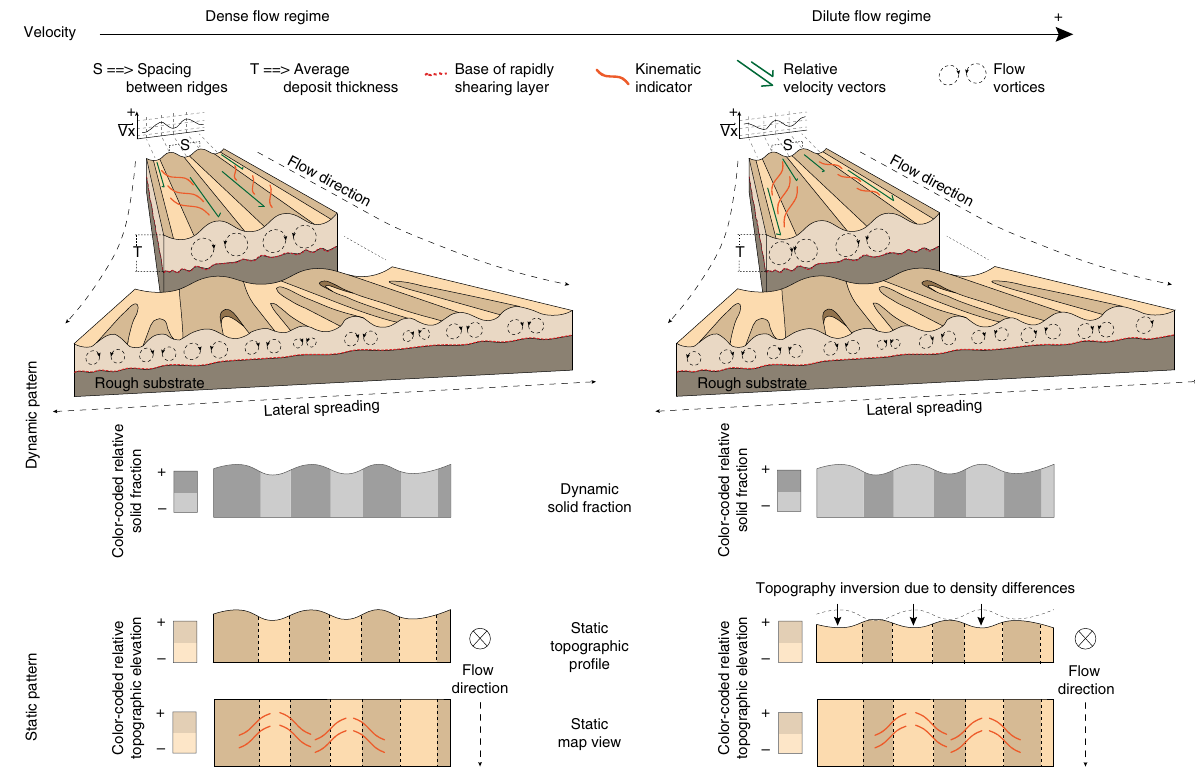
Fig. 4 Flow structure models. Illustration of the two possible fl ow structure scenarios as inferred from the orientation of the en-echelon features observed superposing longitudinal ridges and interpreted as evidence of a velocity gradient between ridges and furrows. The current static pattern that we observe matches two dynamic patterns, a dense regime fl ow structure and a dilute fl ow regime structure followed by inversion of the topography as the fl ow stops and the ridges de fl